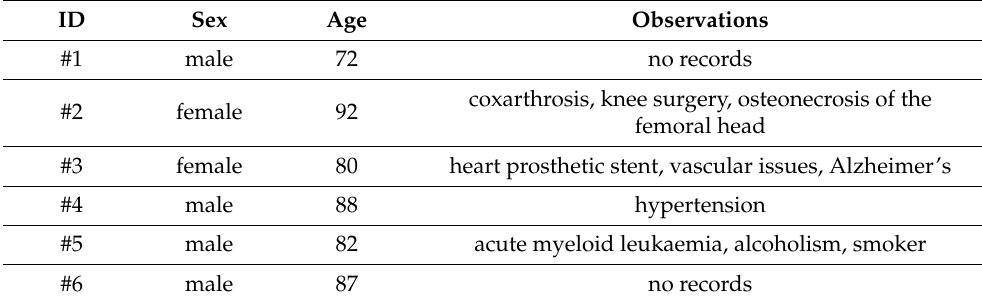
Table 1. Characteristics of the subjects: 4 males and 2 females; mean age of the group 83.5 ( ± 7.1) years